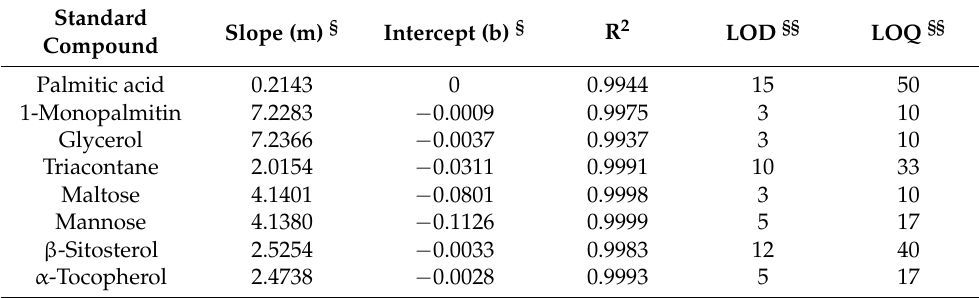
Table 2. Linearity (y = mx + b, where y corresponds to the standard peak area/internal standard peak area ratio and x corresponds to the mass of standard/mass of internal standard ratio), LOD and LOQ of pure compounds used as